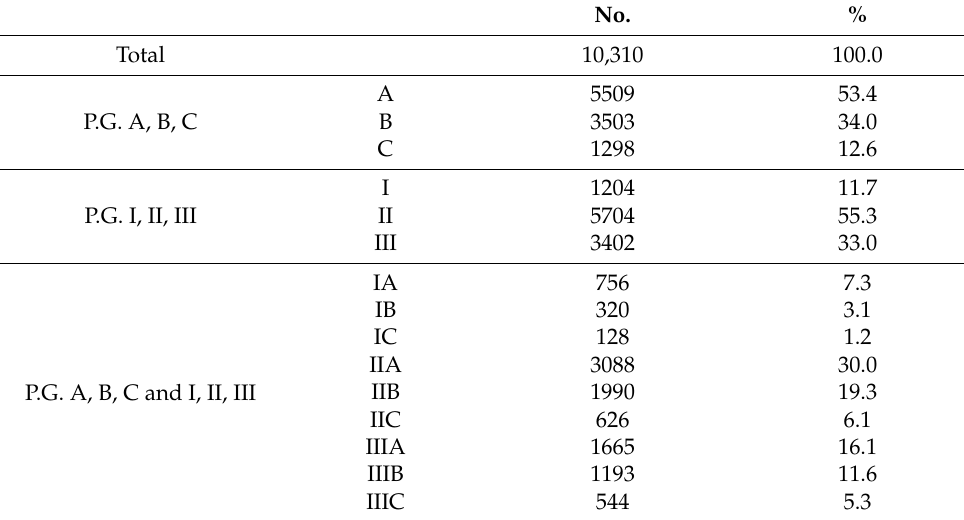
Table 2. Distribution of the Pell and Gregory